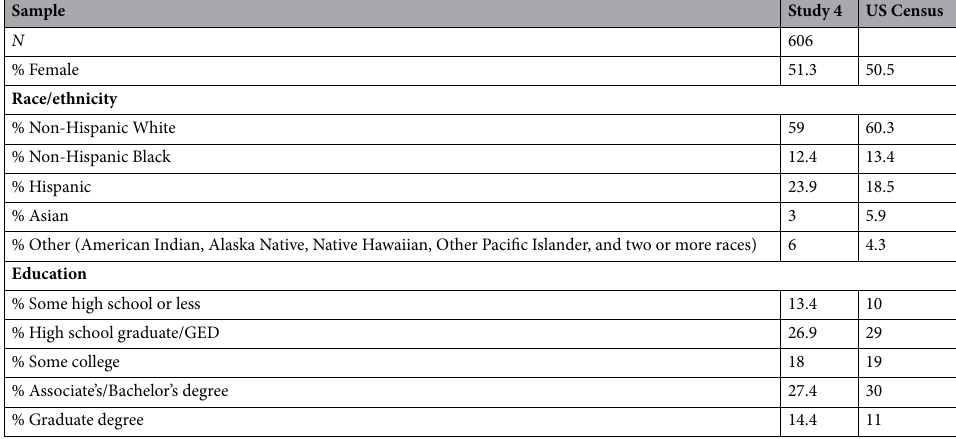
Table 4. Demographic composition of survey respondents in Study 4. The estimates are from the 2019 US